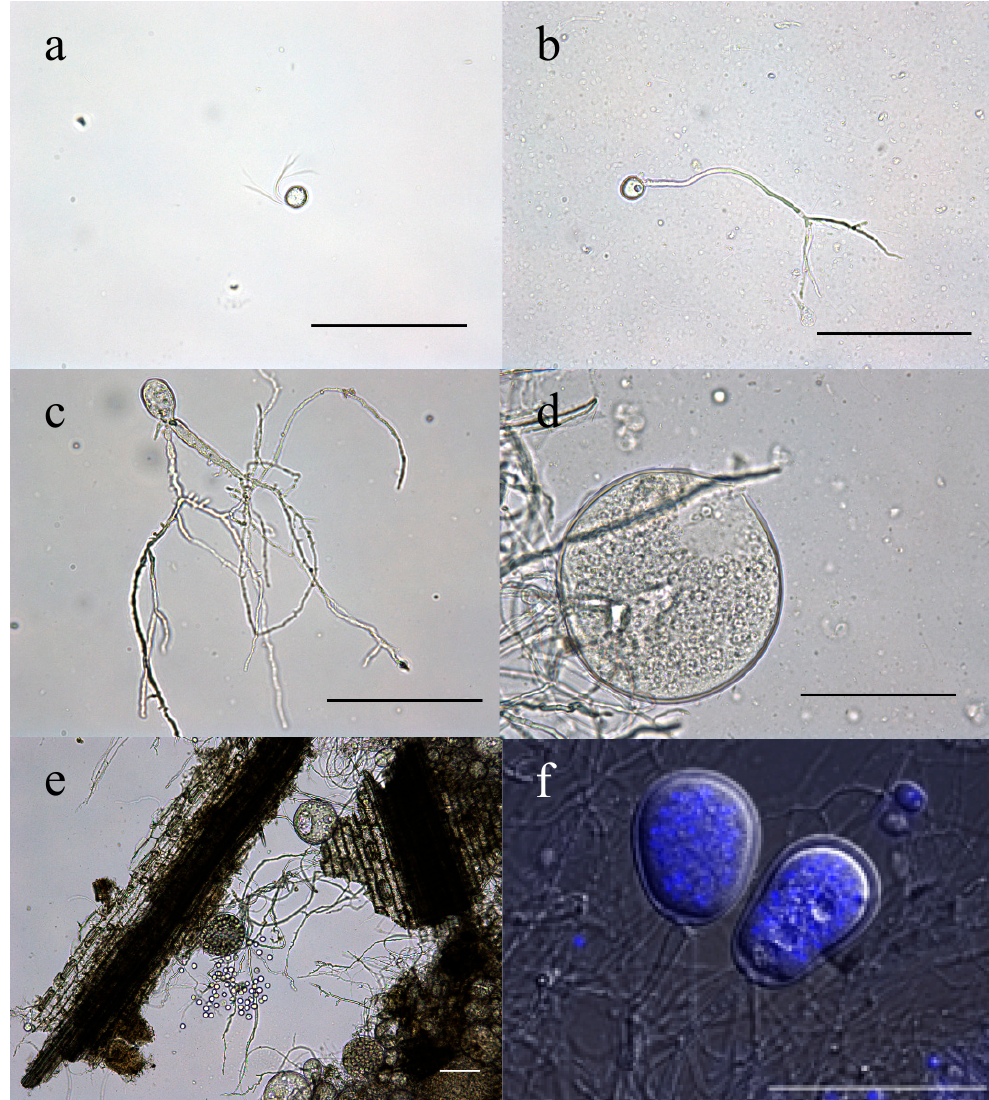
Figure 3. Microscopic features of Aestipascuomyces dupliciliberans type strain A252. Light ( a – e ) and DIC ( f ) micrographs. ( a ) A spherical polyflagellated zoospore with long flagella. ( b – e ) Endogenous sporangia: ( b ) young globose sporangium with a single rhizoidal system, ( c ) ovoid sporangium with two rhizoidal systems, ( d ) large globose sporangium with an apical pore for zoospore release, ( e ) sporangium during zoospore release, and ( f ) 4, 6 diamidino-2-phenylindole (DAPI)-stained mature ellipsoid sporangia. All scale bars are 100 μ m.